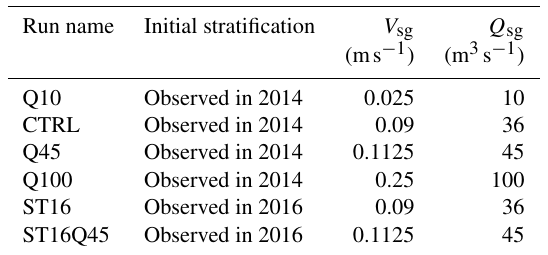
Table 1. List of model runs. Run names, initial stratifications, and values of inflow velocity ( V sg : ms − 1 ) and flux of subglacial dis- charge ( Q sg : m 3 s − 1